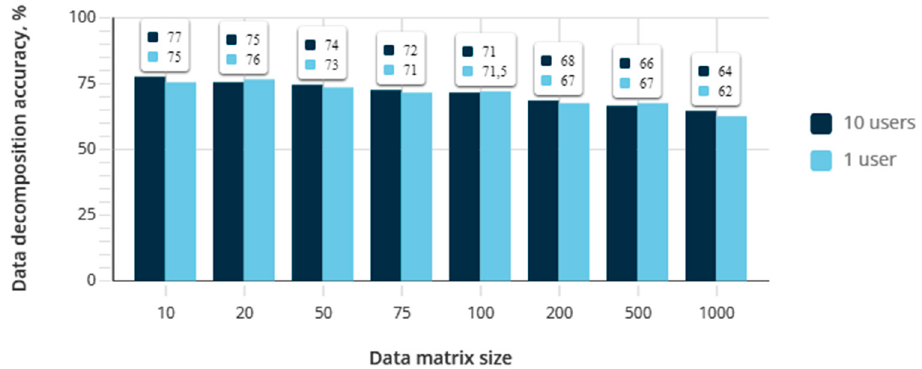
Figure 9. Data decomposition accuracy for the Funk SVD algorithm depends on the number of users involved in providing recommendations.